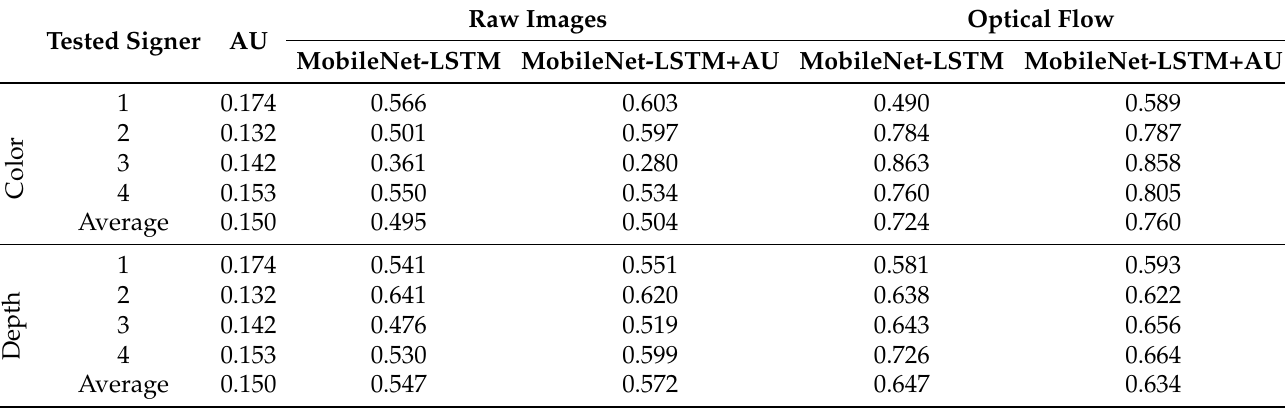
Table 5. Signer-independent recognition accuracies of manual gestures and the principal non-manual articulators using facial expressions (AU in the table refers to animation units representing facial expressions alone). Tested Signer